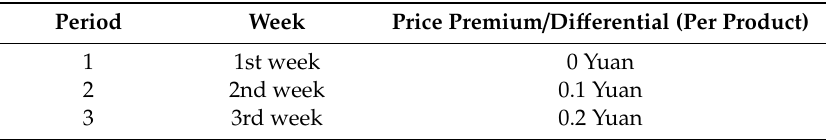
Table 3. Price premiums in different sales periods.